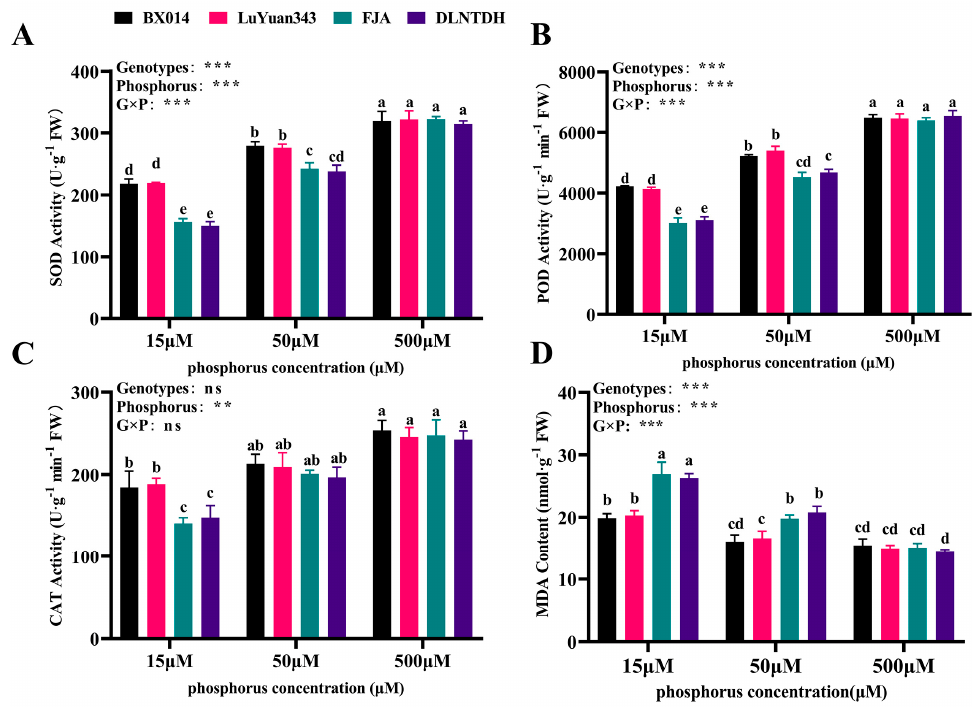
Figure 4. Various P treatments’ effects on antioxidant substances. ( A ) SOD (superoxide-dismutase) activity, ( B ) POD (peroxidase activity, ( C ) CAT (catalase) activity, and ( D ) MDA (malondialdehyde) content in the cotton genotypes, fully expanded barley leaves. The results are expressed as means ± SE ( n = 7). Statistically significant changes are indicated by different letters, using the two-way ANOVA and multiple-comparison test ( p ≤ 0.05). p -values of the ANOVAs of genotypes (G), phosphorus level (P), and their interaction (G × P) are indicated as ns, not significant; **: p < 0.01, ***: p <